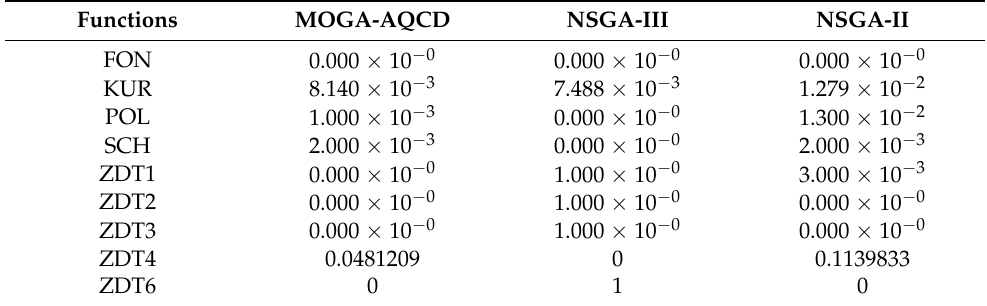
Table 8. Average set coverage of MOGA-AQCD, NSGA-III, and NSGA-II compared to that of HAES.